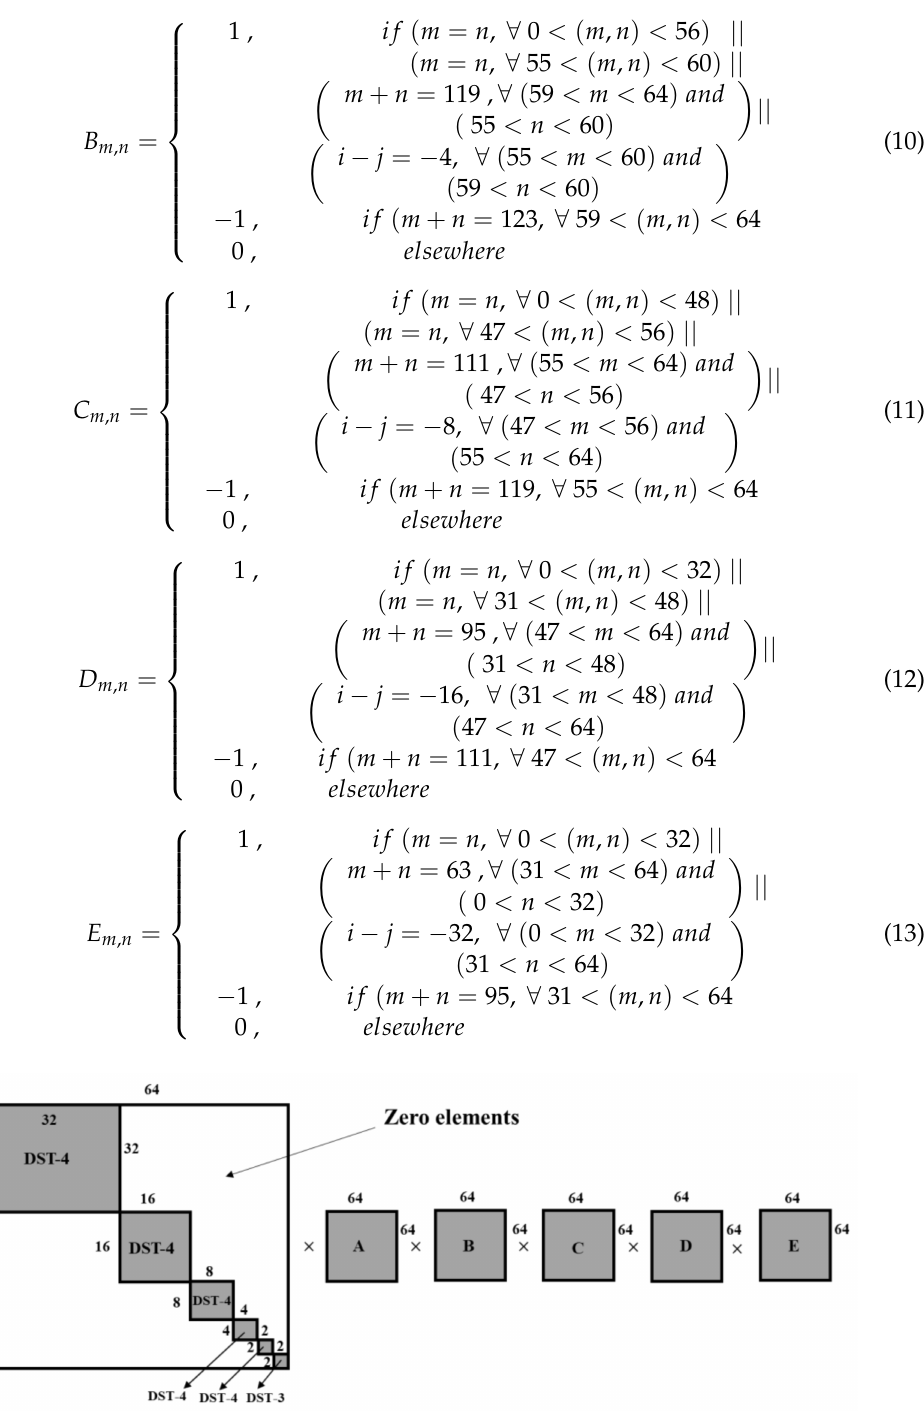
Figure 3. DST-3 derivation mechanism from unified DST-3 matrix ( U